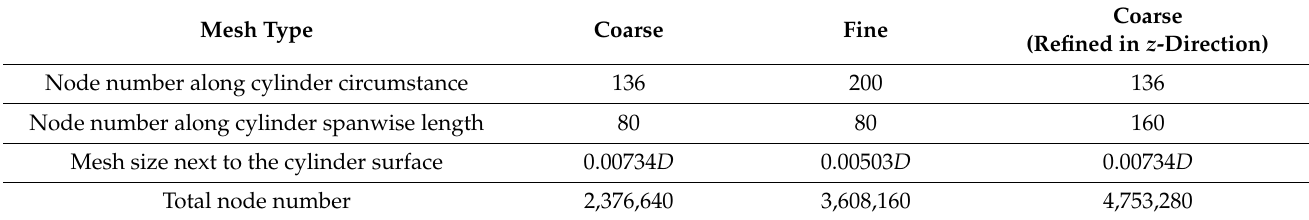
Table 1. Main parameters of the coarse and fine meshes used in the present